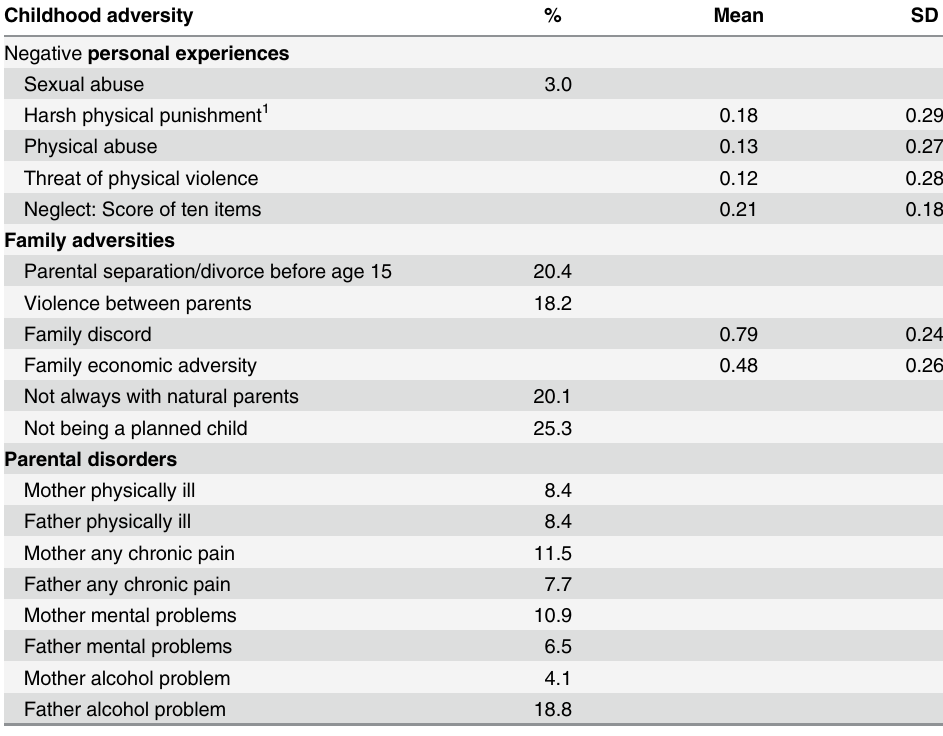
Table 2. Prevalences of childhood